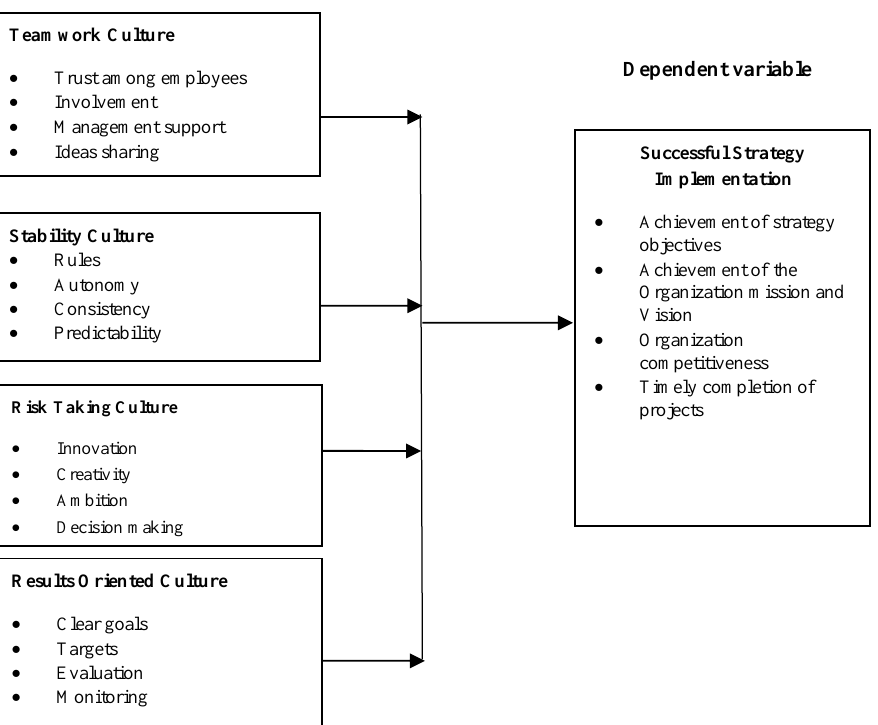
Figure 1: Conceptual